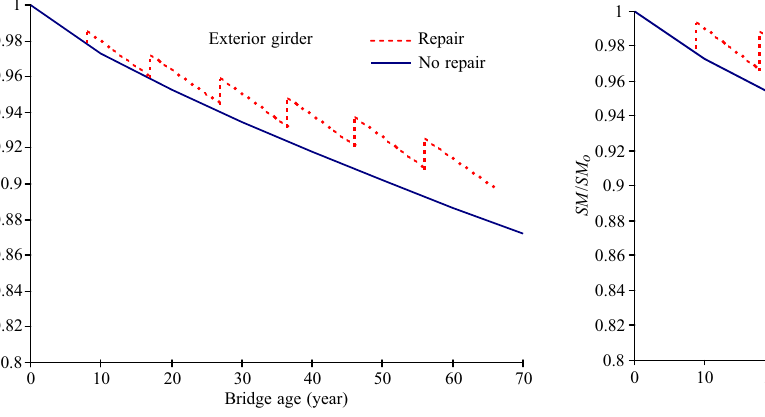
Fig. 9. Variation in the ultimate moment of the interior girder of the bridge with age